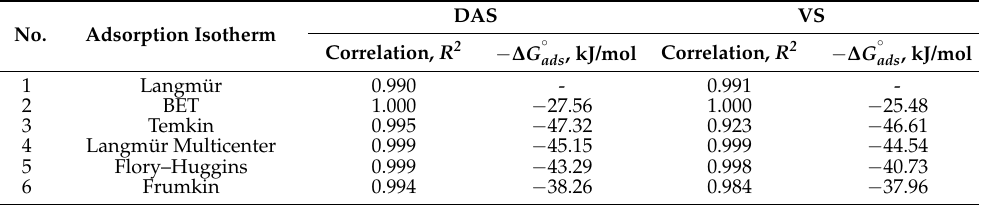
Table 3. Adsorption isotherms to describe the adsorption of organosilanes from diluted aqueous solutions.